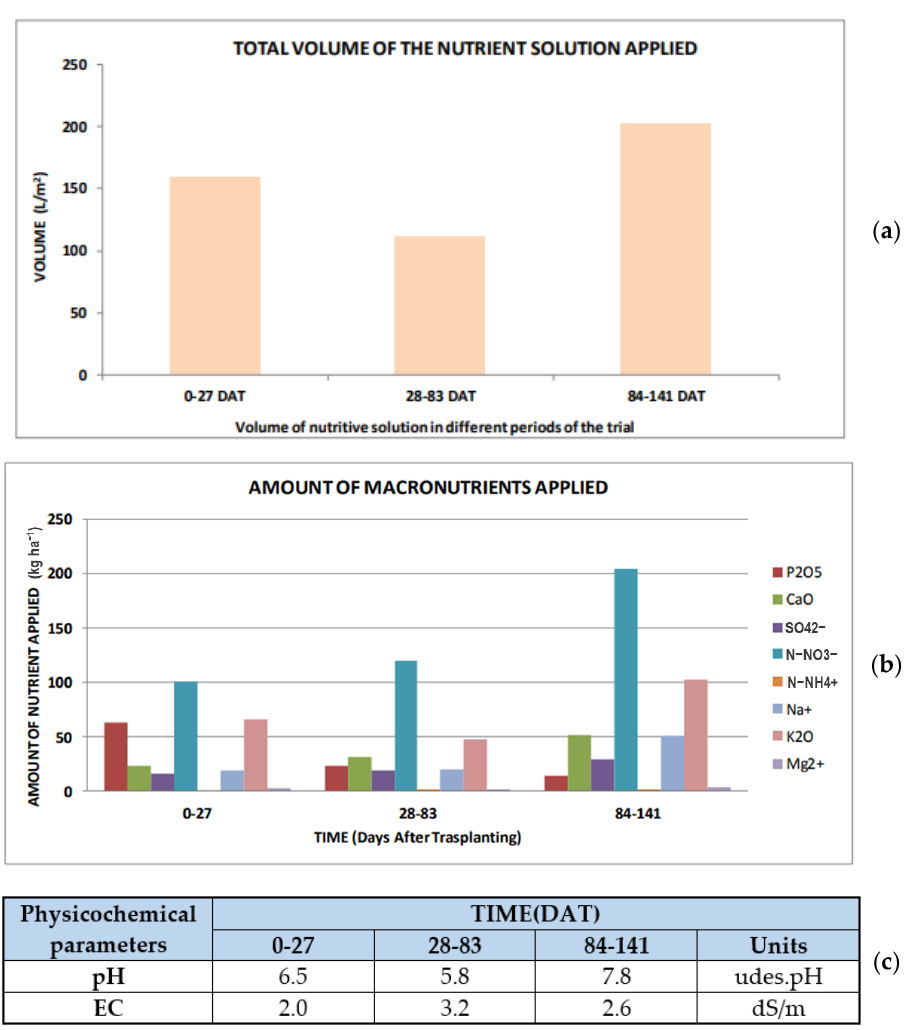
Figure 2. Amount of applied fertilizers: ( a ) total volume of the nutrient solution applied; ( b ) amount of macronutrients applied; ( c ) physical-chemical parameters of the irrigation water.